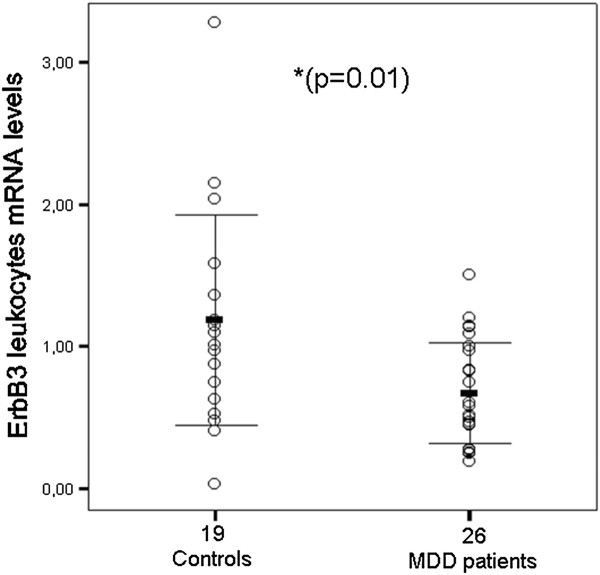
ErbB3 leukocytes mRNA levels in controls and MDD patients. Error bars show mean ± 1.0 SD. Expression levels by RT-PCR are the threshold cycle (Ct) values converted to RNA equivalents and then normalized to geometric mean of housekeeping genes expression.